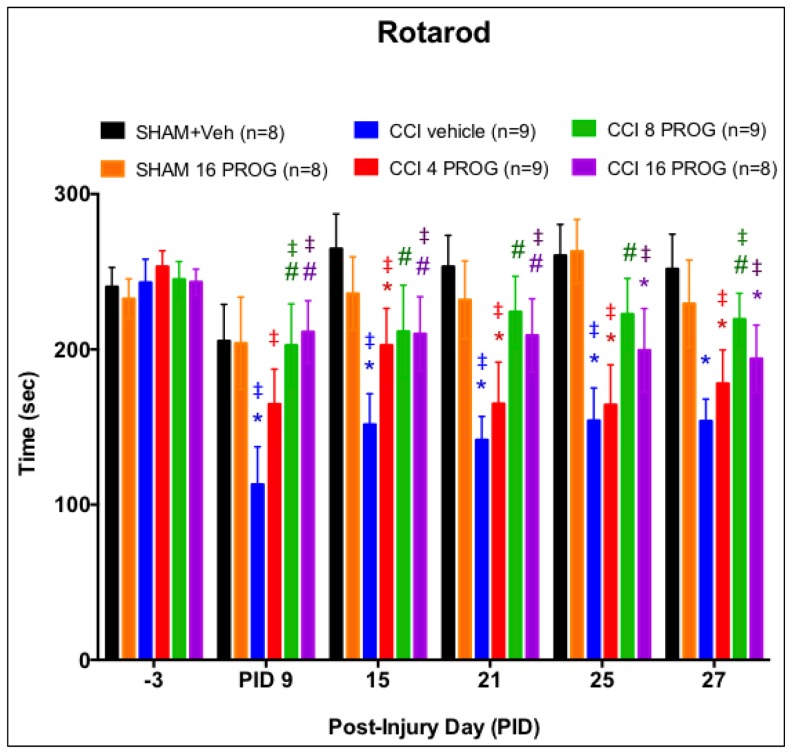
Dose-response effect of progesterone treatment on vestibulomotor function.Progesterone-treated rats showed improvement in balancing and walking on the rotarod tasks. * =  different from sham + vehicle; # =  significantly different from CCI+ vehicle (p's<0.05). ‡ =  significant difference from baseline within each group (color coded). Values are mean ±SEM (n = 8–9). PROG =  progesterone.